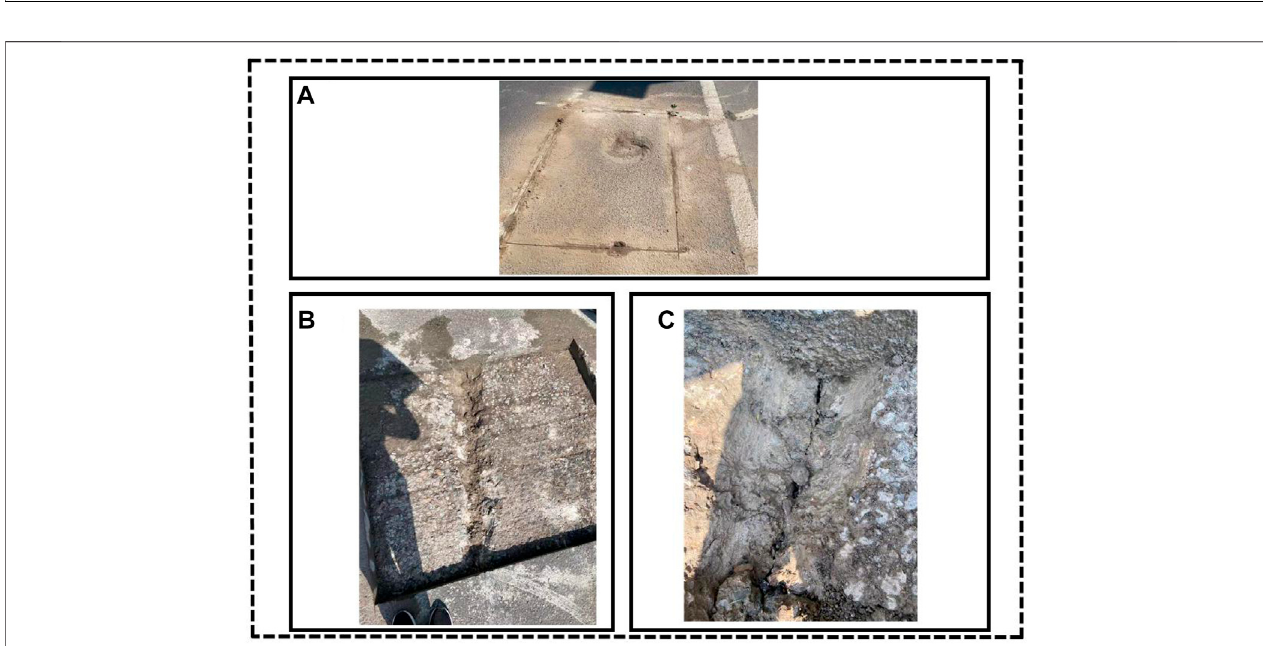
FIGURE 8 | Typical diseases: (A) local settlement of asphalt pavement; (B) removal of asphalt pavement surface; and (C) re fl ection crack of base course.